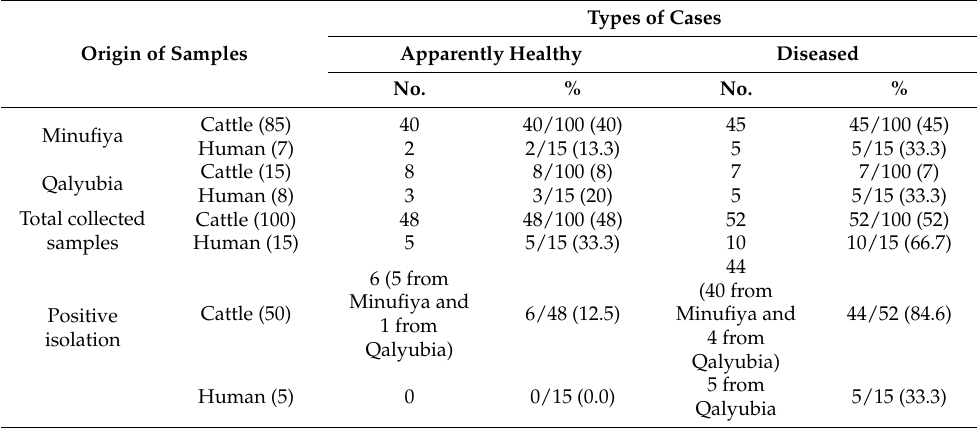
Table 1. Results of collected samples, origin, and types of